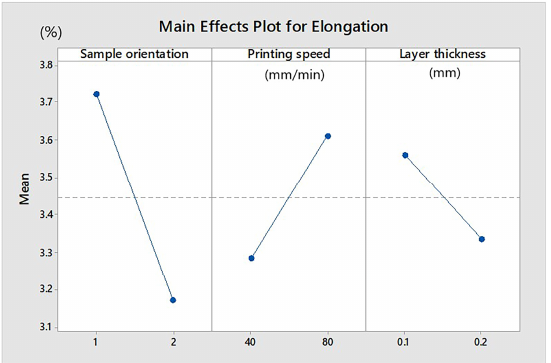
Figure 4. Influence of parameters on elongation (Extrudr BDP Flax samples). Sample orientation: 1—plan and 2—on edge.